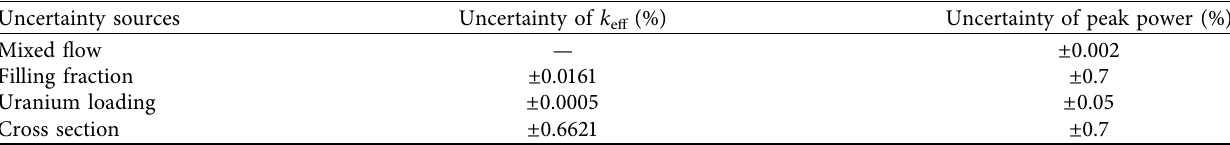
Table 1: Summary of peak power uncertainty due to different uncertainty